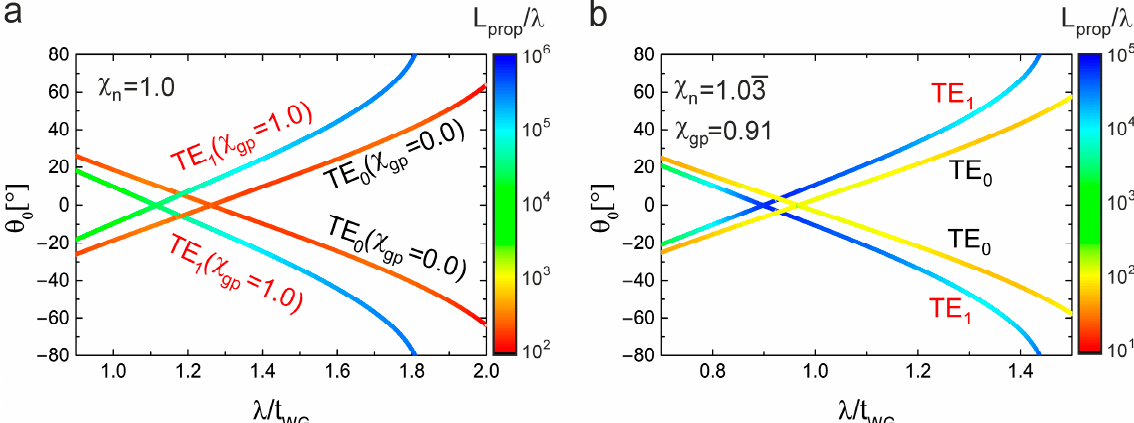
Figure 5. ( a ) The dispersion relations and normalized propagation lengths of the TE 0 mode for χ gp = 0.0 and the TE 1 mode for χ gp = 1.0 under fixed ratios of all geometry parameters as used in Figure 3 (only the wavelength is varied with respect to the geometry) and χ n = 1; ( b ) dispersion relations and normalized propagation lengths for an asymmetric geometry with χ gp = 0.91, χ n = 1.03 for both the TE 0 mode and TE 1 mode with t g t d 1 + t d 2